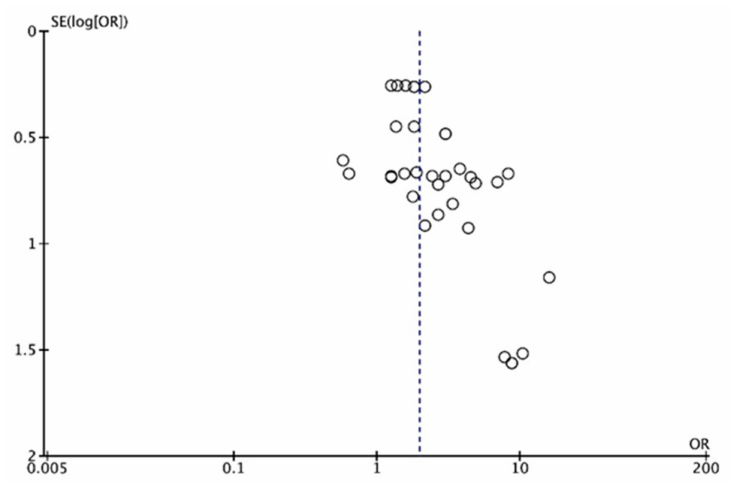
Figure 3. Funnel plot. Each dot indicates one of the 34 results from the ten included studies. The y axis represents the standard error (SE) of the OR, and the x-axis represents the OR calculated in the meta-analysis.